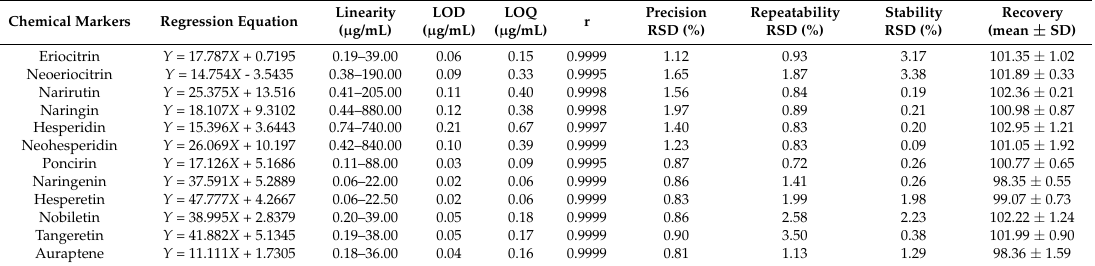
Table 3. Linearity, LOD, LOQ, precision, repeatability, stability and recovery of the 12 chemical markers. ChemicalMarkers